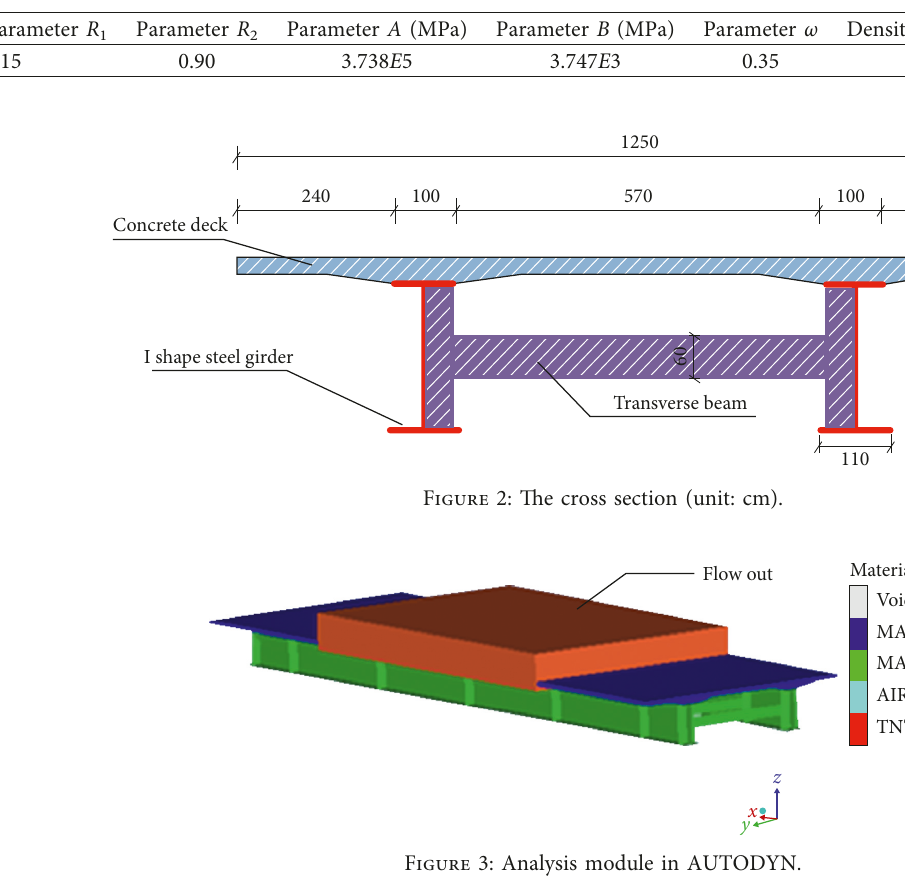
Table 2: Material parameters of JWL equation state.